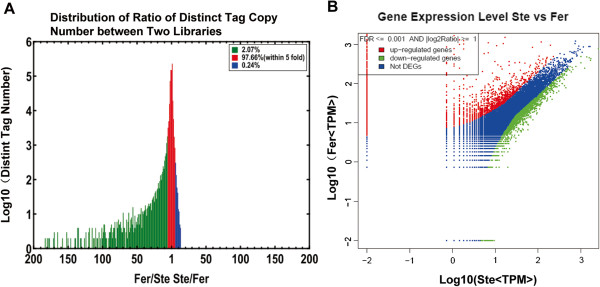
Differentially expressed tags and corresponding genes in Ste and Fer.A, Differentially expressed tags in Ste and Fer. The “x” axis represents fold-change of differentially expressed unique tags in two libraries. The “y” axis represents the number of unique tags (log10). Differentially accumulating unique tags with a 5-fold difference between libraries are shown in the red region (97.66%). The blue (0.24%) and green (2.07%) regions represent unique tags that are up- and down-regulated for more than 5 folds in the Fer and Ste libraries, respectively. B, Comparision of gene expression levels between the two libraries. For comparing gene expression levels between the two libraries, each library was normalized to 1 million tags. Red dots represent transcripts more prevalent in Fer library, green dots show those present at a lower frequency in Fer and blue dots indicate transcripts that did not change significantly. The parameters “FDR <0.001” and “log2 Ratio ≥ 1” were used as the threshold to judge the significance of gene expression difference.